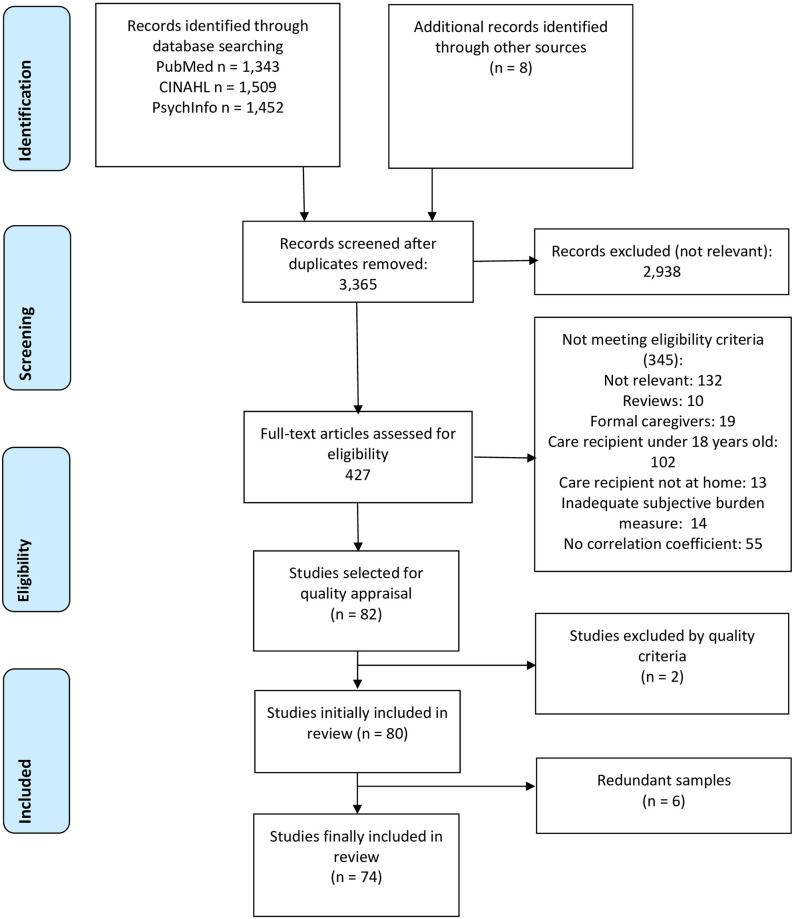
Flow diagram (PRISMA).